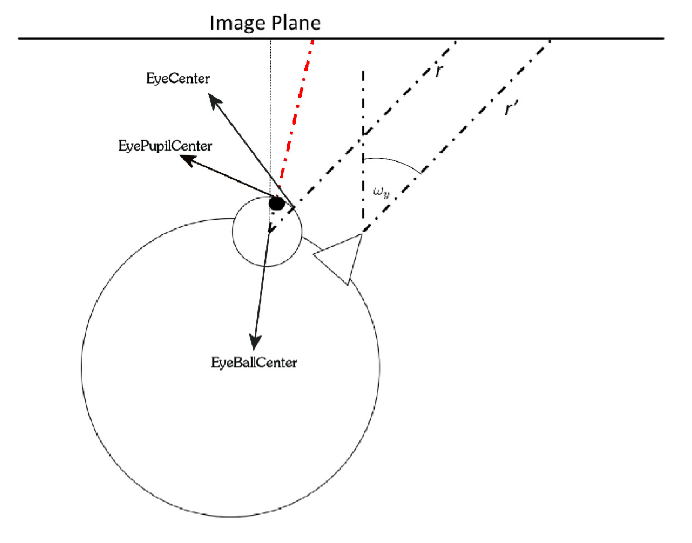
Figure 7. A schematic representation of the gaze